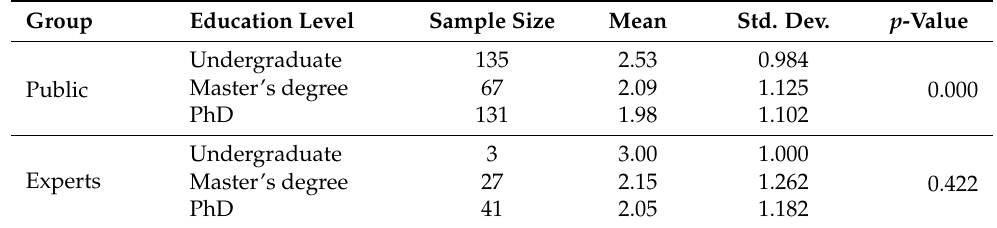
Table 5. Differences in perceptions on wind turbines technology, grouped by level of education.